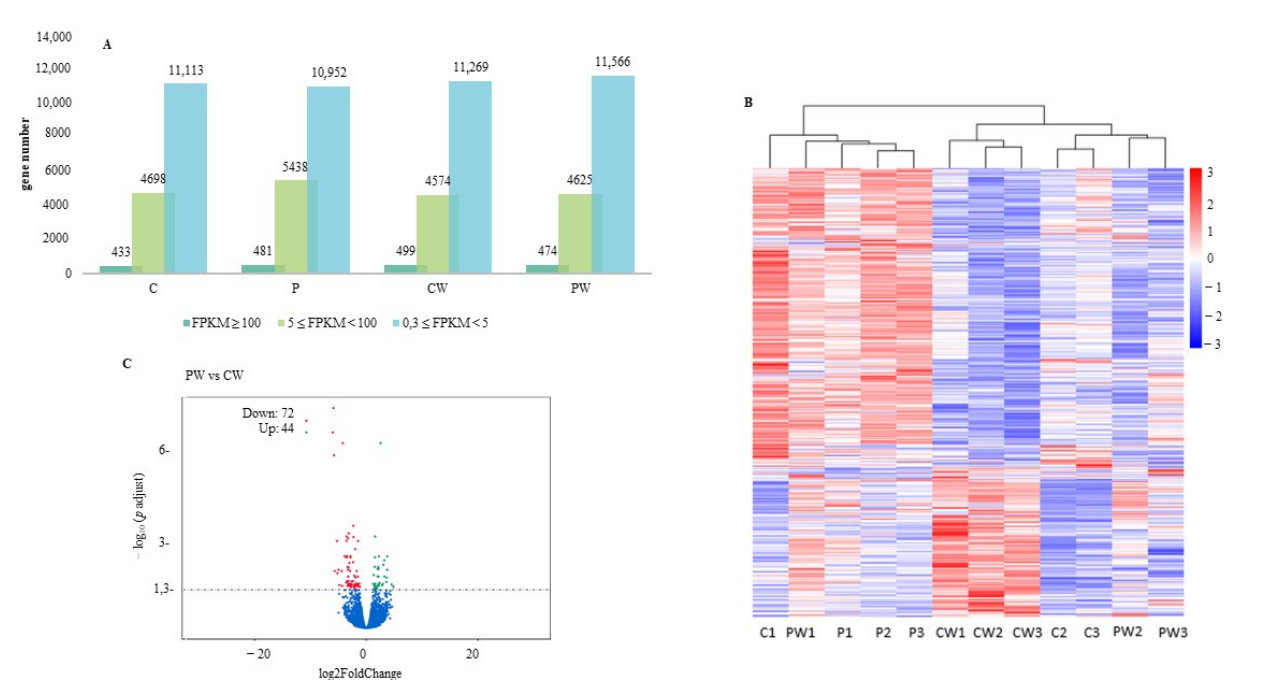
Figure 6. ( A ) Number of genes expressed during each stage with an average number of reads per kilobase per million reads (FPKM) of ≥ 0.3. ( B ) Heatmap by sample using the log10 (FPKM + 1) value. Red indicates genes with high levels of expression, while blue indicates low levels. The red to blue color scale represents the log10 (FPKM + 1) value from highest to lowest. ( C ) Volcano plots of differentially expressed genes (DEGs) between PW vs. CW comparison, expression data plotted with correct p value cutoff FDR < 0.05 and log 2 fold change absolute value ≥ 1.3 Fish feed with control diet without (C) and with wound (CW). Fish feed with probiotic diet without (P) and with wound (PW). 1–3 represent biological replicates.